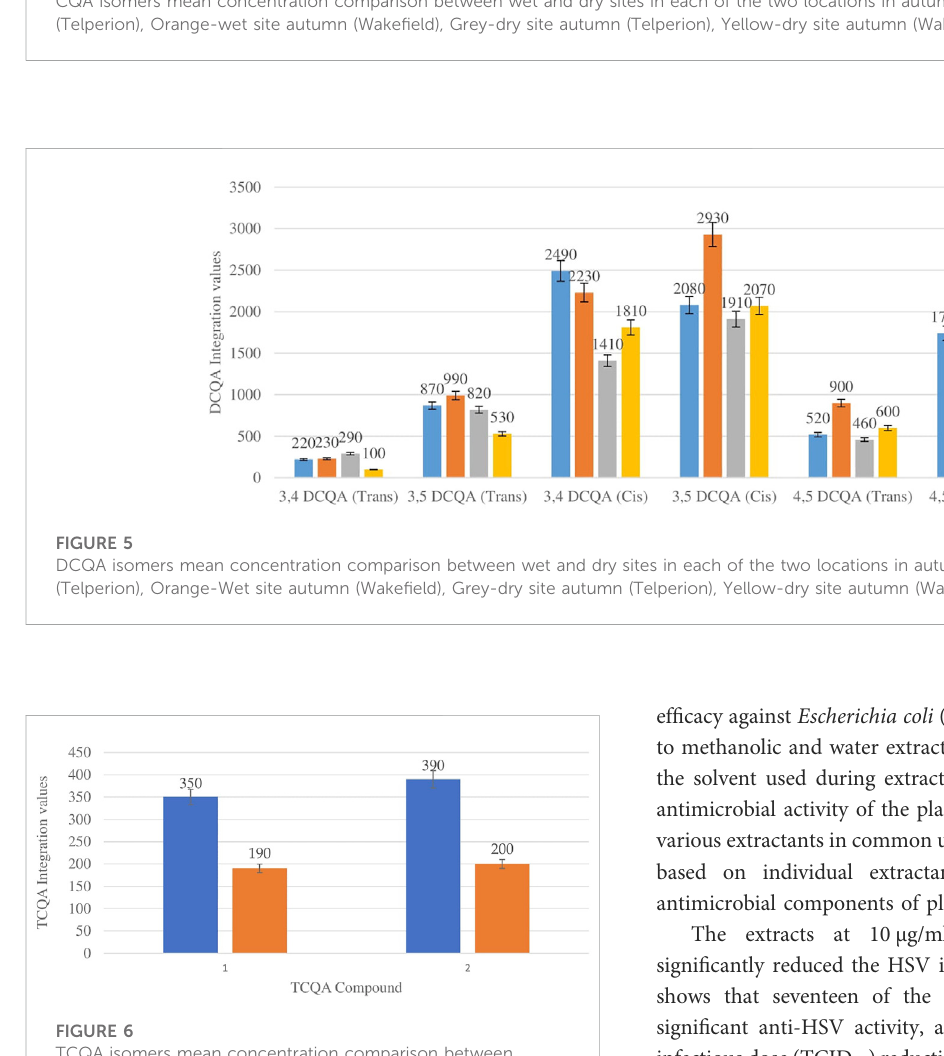
FIGURE 6 TCQA isomers mean concentration comparison between wet and dry sites from Telperion and Wake fi eld in autumn. 1st Blue-Wet site Telperion, 1st Orange-Dry site Telperion, 2nd Blue- Wet site Wake fi eld, 2nd Orange-Dry site Wake fi